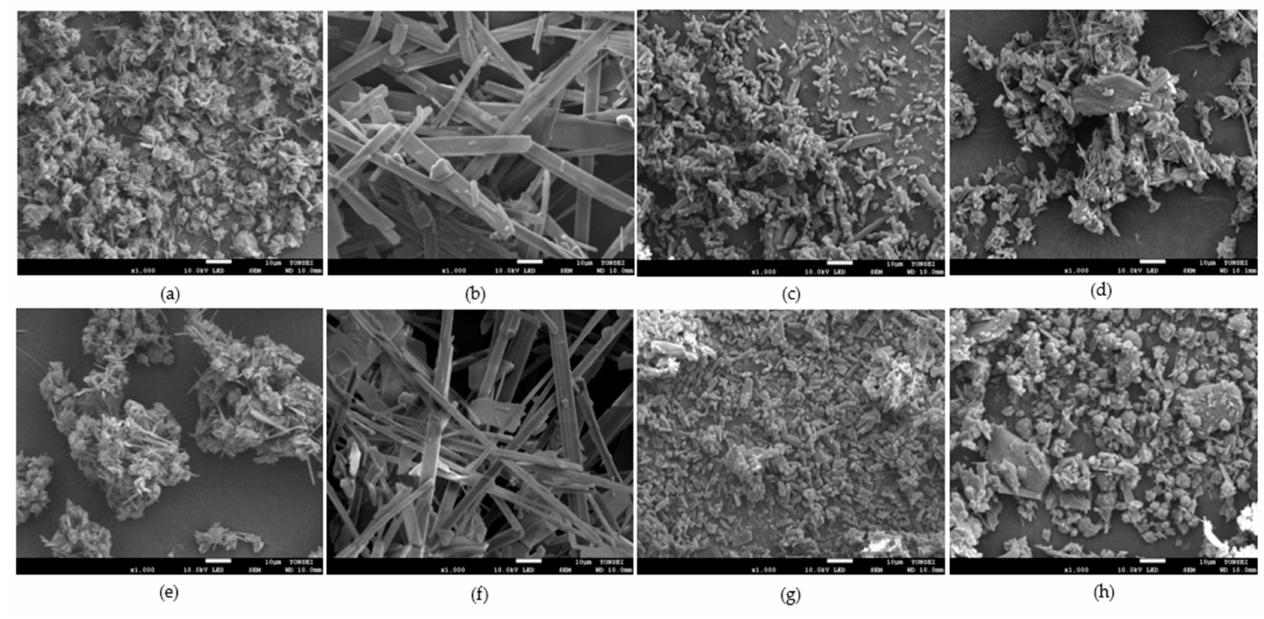
Figure 8. SEM image of ( a ) evaporation crystallization CEL-ADI EM; ( b ) SAS CEL-ADI EM; ( c ) SCF assisted mixing CEL-ADI EM; ( d ) spray drying CEL-ADI EM; ( e ) evaporation crystallization CEL-SAC EM; ( f ) SAS CEL-SAC EM, ( g ) SCF-assisted mixing CEL-SAC EM, ( h ) spray-dried CEL-SAC